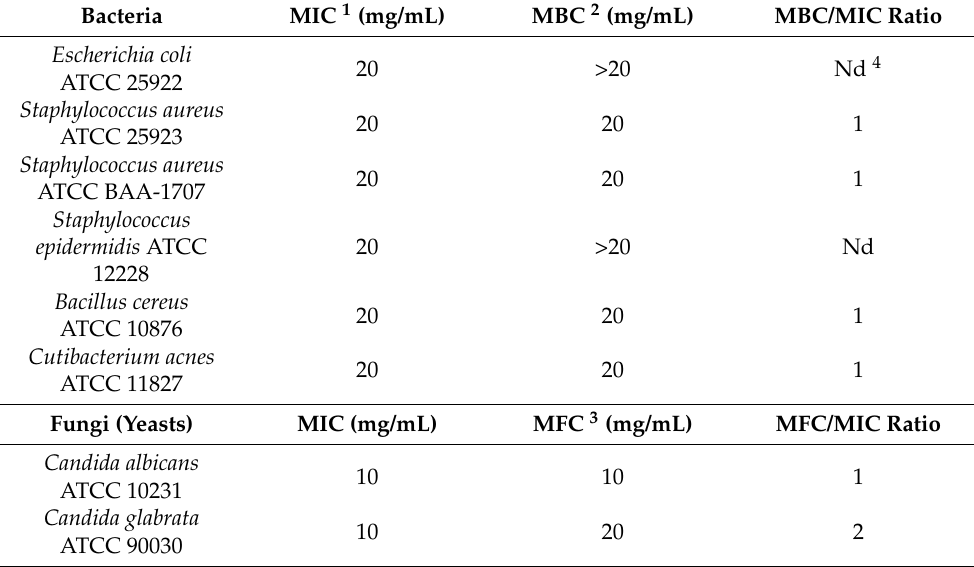
Table 3. The activity of CA extract towards bacterial and fungal reference